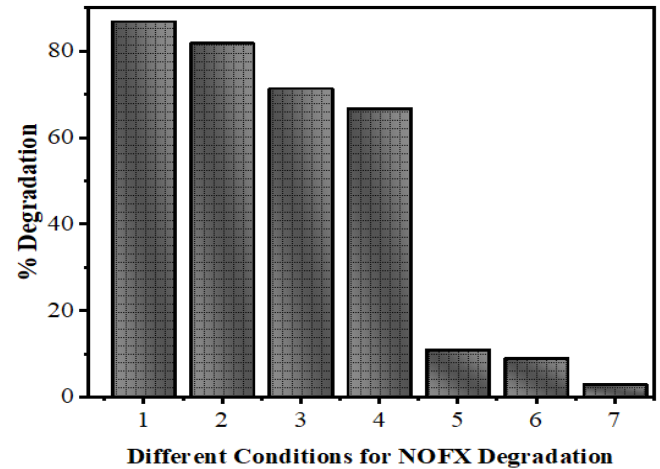
Figure 11. Efficiency of ZnS QDs for NOFX (15 mg/L) obtained in different conditions under optimal parameters (25 mL of SDB, pH 10, 60 min irradiation, 60 mgs QDs).(1) Mn:ZnS + UV, (2) Pure ZnS + UV, (3) Mn:ZnS + Sunlight, (4) Pure ZnS + Sunlight, (5) UV light (no catalyst), (6) ZnS QDs, (7) Blank (without light and catalyst).